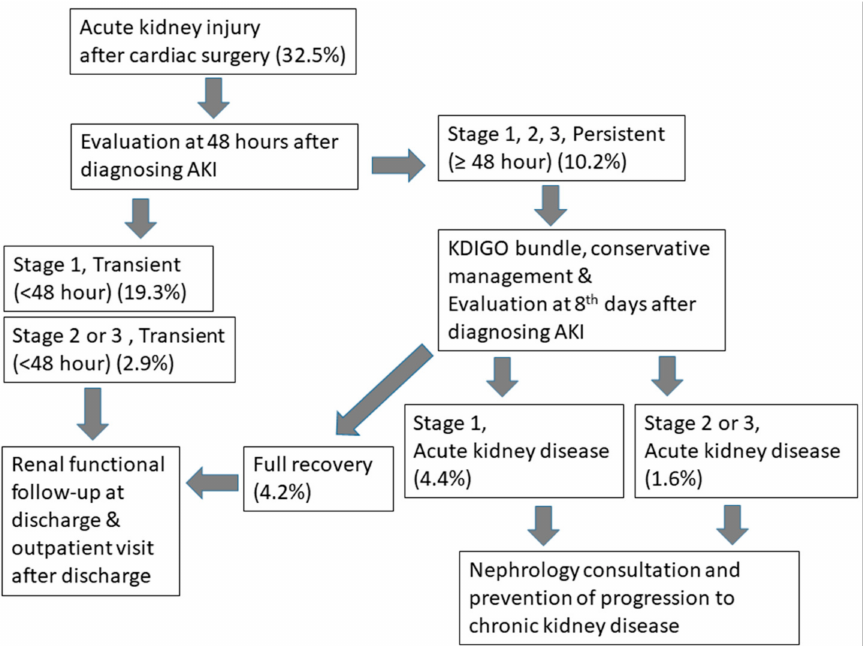
Figure 4. Cubic spline function curves of the relationship between the duration of acute kidney injury and the probability of developing chronic kidney disease, as determined by estimated glomerular filtration rate of less than 60 mL/h/1.73 m 2 . CKD = chronic kidney